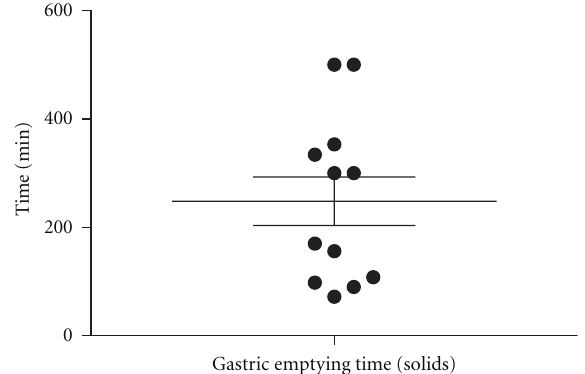
Figure 2: Frequency distribution of solid-phase gastric emptying times. Scan was performed over 90 minutes. Data was available for 14 of 24 patients. Mean emptying time was 204 minutes. Emptying times greater than 200 minutes are suggestive of gastroparesis.